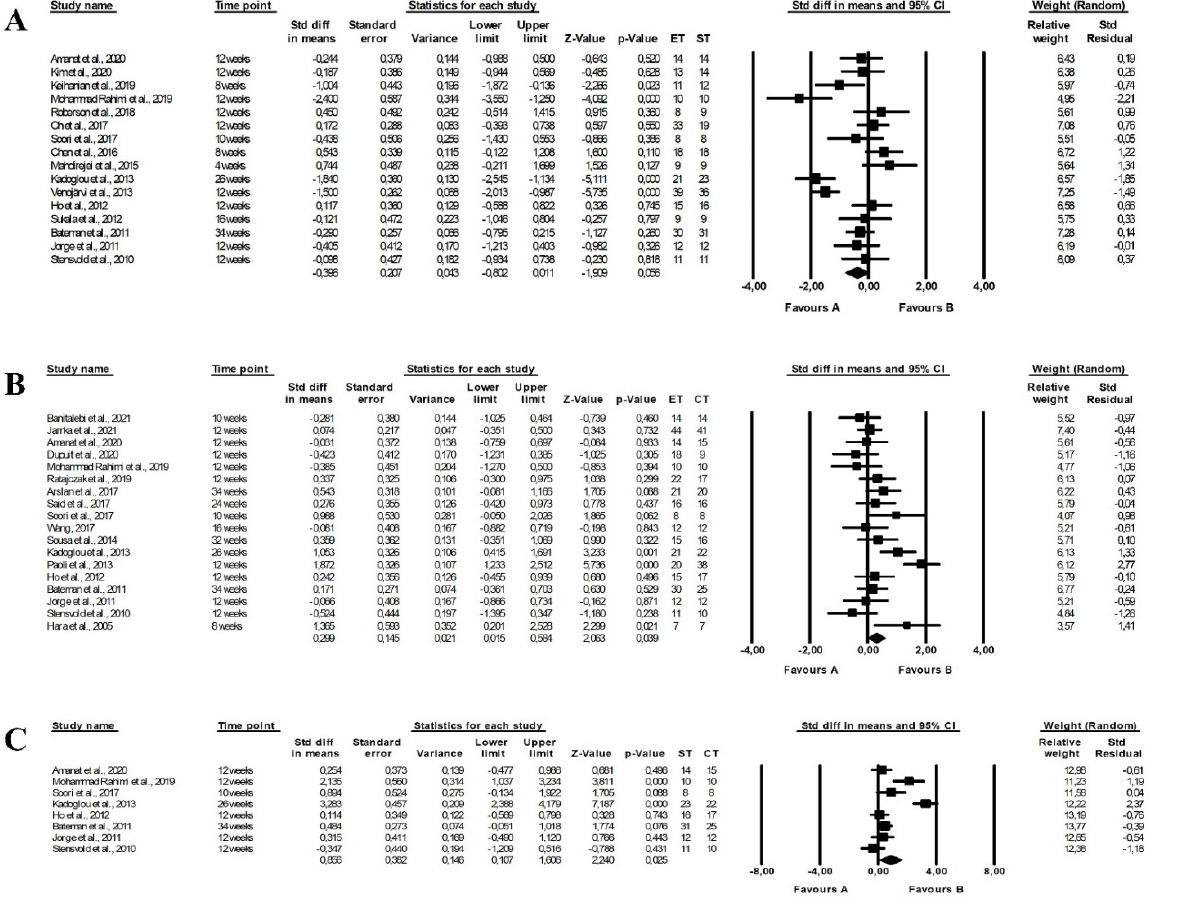
Figure 12. Forest plots of the effect of training programmes on triglycerides levels: ( A ) endurance (favours A) vs. strength (favours B) training (random model) [13,14,22,41,43,45,46,49,53,55,57,63,65,66, 68,69]; ( B ) endurance (favours A) vs. endurance-strength (favours B) training (random model) [13,22, 37–39,41,46,47,52,54–56,60,63,64,66,69,72]; ( C ) strength (favours A) vs. endurance-strength (favours B) training (random model) [13,22,41,46,55,63,66,69]. CI—confidence interval; CT—combined training; ET—endurance training; ST—strength training; Std—standard; Std diff—standard